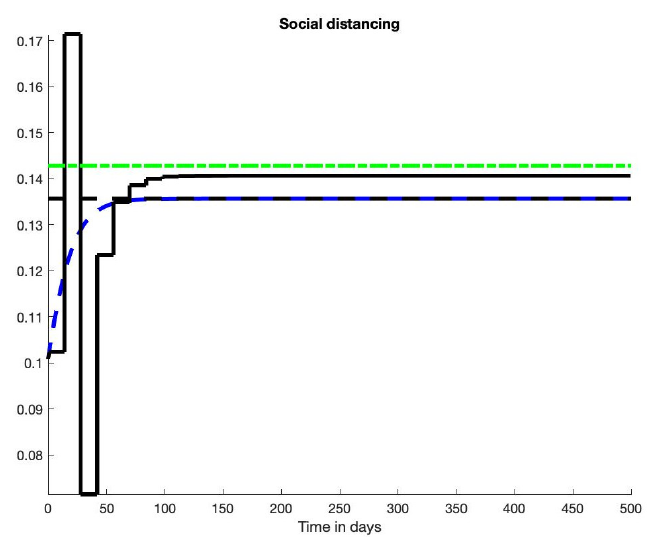
Figure 10. Scenario 5: States. ( a ) S and S ∗ (- -); ( b ) I and I ∗ (- -).